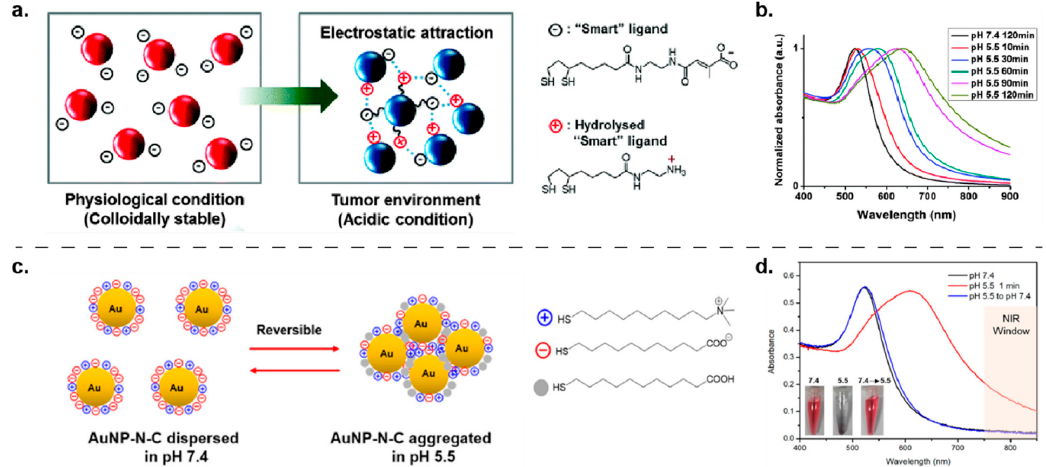
Figure 8. Schematic representation of pH-triggered AuNP aggregation through two different mechanisms. ( a ) The surface charge of AuNPs is designed to switch from negative to a mixture of negative and positive charges through bond cleavage under the mildly acidic conditions; once the surface charge is neutralized, AuNPs begins to aggregate due to the absence of electrostatic repulsion. (Adapted with permission from Reference [130]; Published by Royal Society of Chemistry, 2016). This transformation was monitored by ( b ) UV–vis spectroscopy for 2 h. ( c ) The surface charge of AuNPs is designed to be neutralized owing to the protonation of MUA ligand under the mildly acidic conditions. As demonstrated by UV–vis spectroscopy ( d ), this transformation is reversible. (Adapted with permission from Reference [132]; Published by American Chemical Society, 2017).